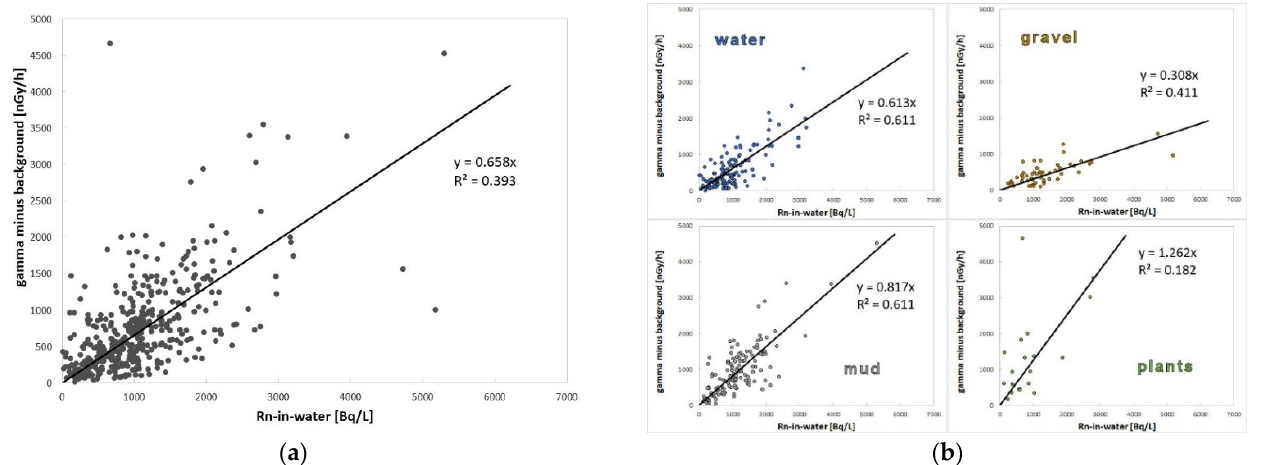
Figure 3. Relationship of the gamma dose rate-in-water and radon-in-water activity. Data from the whole Lugian area ( a ) divided into four environmental groups according to the substrate where the gamma dose rate was measured: water, gravel, mud, and living plants ( b ).